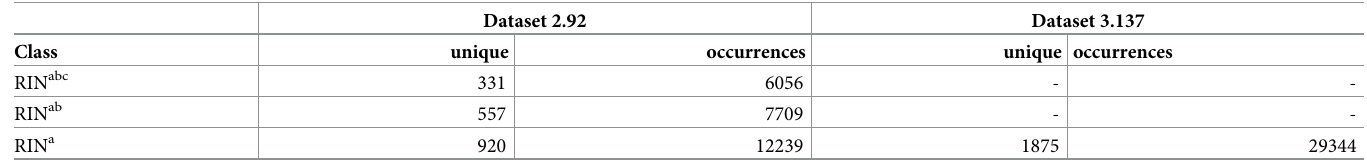
Table 4. Summary of numbers of unique RINs found in the different classes with the total numbers of occurrences. Please note that this table also displays the numbers for the RIN a class in Dataset 3.137 that we will present in section 3.4.